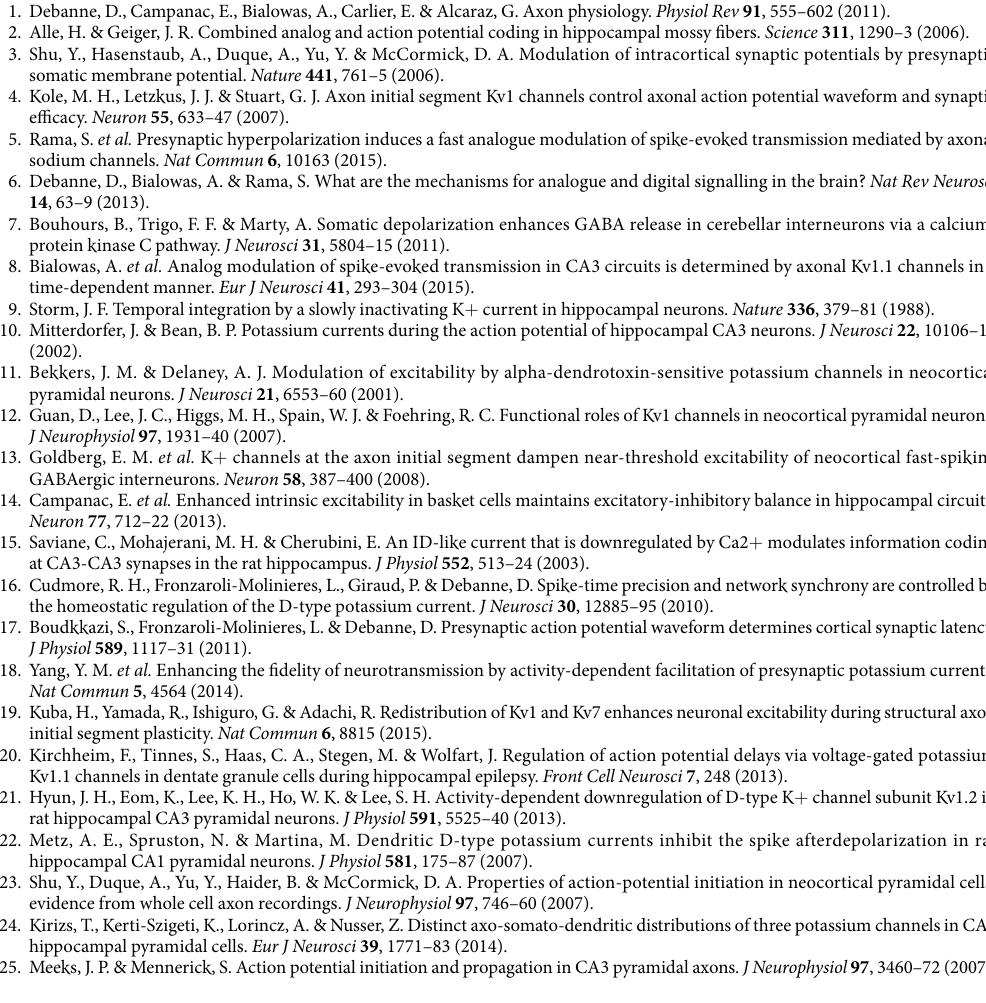
Supplementary Table 1. For jitter simulation, we added a Gaussian noise to the injected current (mean: 0; var- iance: 0.1 pA 2 ). Cutting experiments were modeled by simply reducing the length of the considered neurite to 0.01 µ